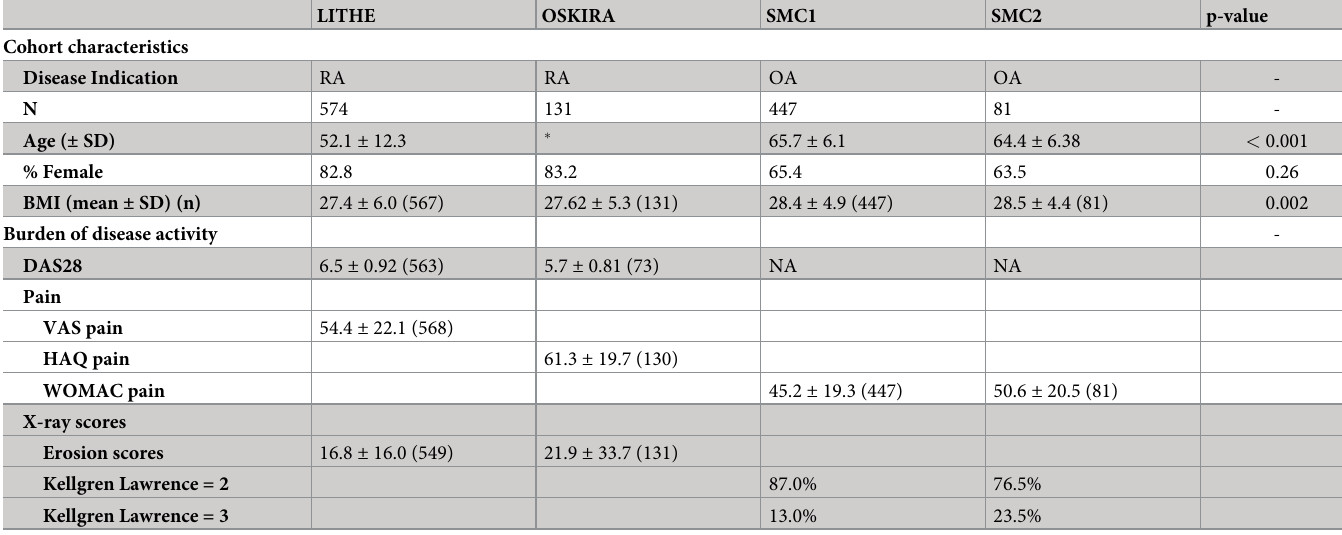
Table 1. Baseline patient demographics for four cohorts used in this study, LITHE, OSKIRA, SMC1 and SMC2. All measurements were taken at the start of each of the clinical trials prior to treatment.